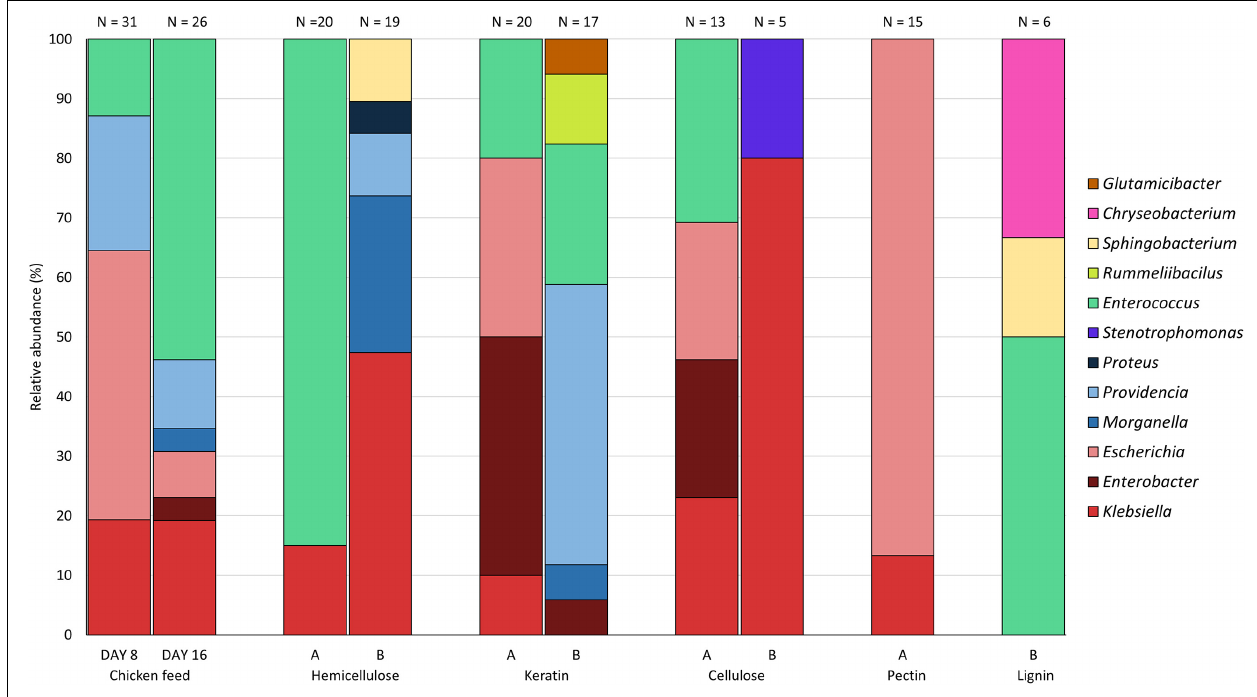
FIGURE 3 | Relative abundance of the genera isolated from black soldier fly larvae fed on chicken feed and various fiber-rich diets (A = 70% chicken feed and 30% fiber; B = 30% chicken feed and 70% fiber). Isolates from larvae fed on chicken feed were obtained at days 8 and 16, whereas isolates from fiber-rich substrate were only obtained at day 16. N is the number of isolates obtained from larvae fed on the specific fiber-rich